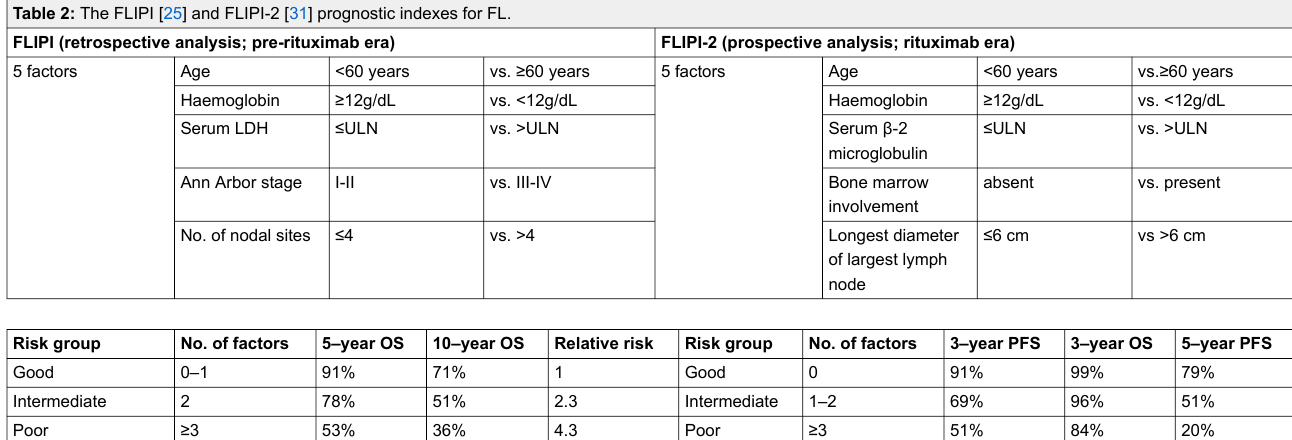
Table 2: The FLIPI [25] and FLIPI-2 [31] prognostic indexes for FL. FLIPI (retrospective analysis; pre-rituximab